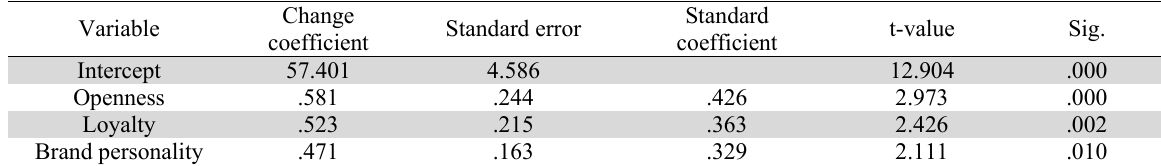
The summary of Stepwise